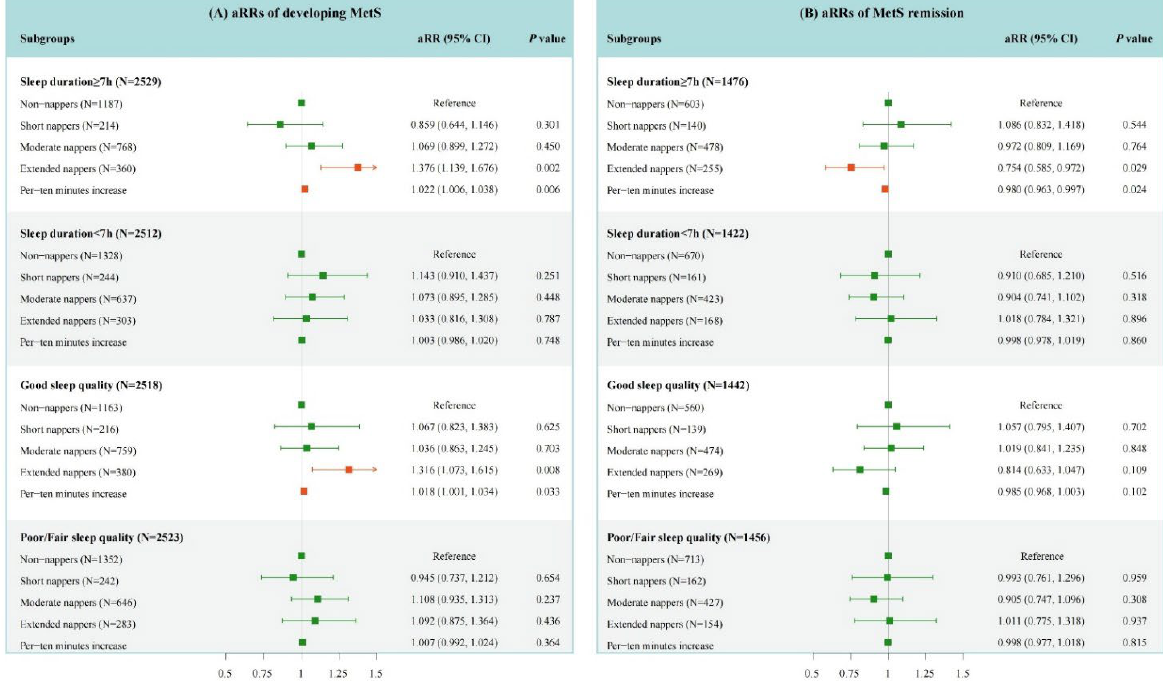
Figure 1. Longitudinal dose–response relationship between baseline daytime napping duration and the incidence of MetS. The curve was estimated by restricted cubic spline function with four knots. Solid lines indicate aRRs. The reference was set to 0 min. The shadow represents 95% confidence intervals.